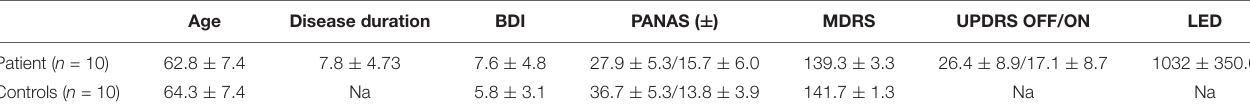
TABLE 1 | Patient characteristics: age (years), disease duration with respect to the date of operation (years), mean score of the Beck depression inventory (BDI), mean score of the positive and negative affect schedule (PANAS), mean score of the Mattis dementia rating scale (MDRS), UPDRS OFF: Score of the motor part of the UPDRS without